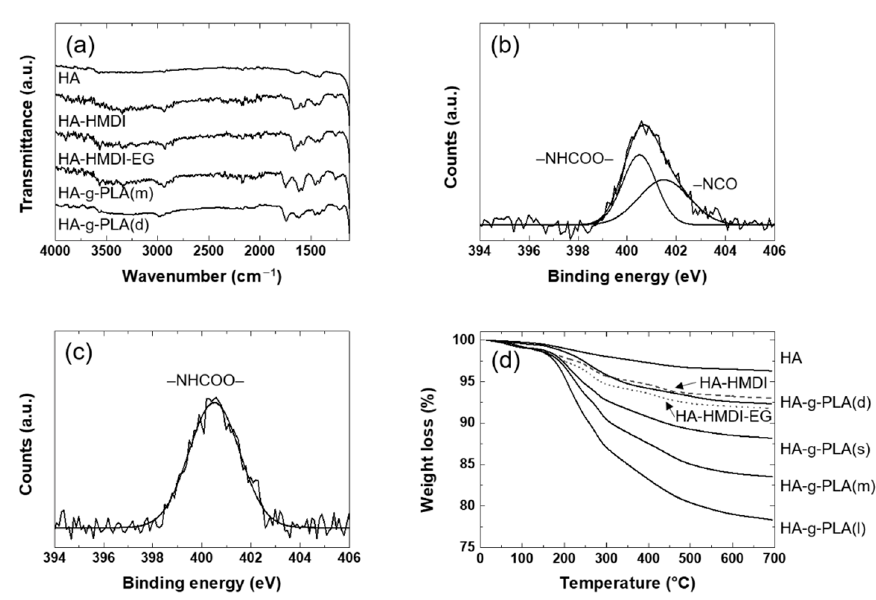
Figure 1. ( a ) FT-IR, ( b ) and ( c ) XPS for N1s, and ( d ) TGA of surface-grafted hydroxyapatite (HA): ( b ) HA-Hexamethylene diisocyanate (HMDI); ( c ) HA-HMDI-ethylene glycol (EG).